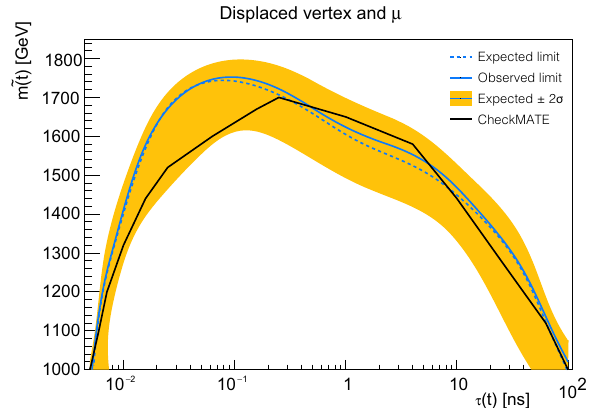
Fig. 3 Comparison of exclusion limits in the stop mass and stop lifetime plane, m ˜ t – τ ˜ t , reported by ATLAS: expected – dashed blue; observed – solid blue and CheckMATE – black solid. The yellow band shows a 2-sigma range of the ATLAS expected exclusion limit